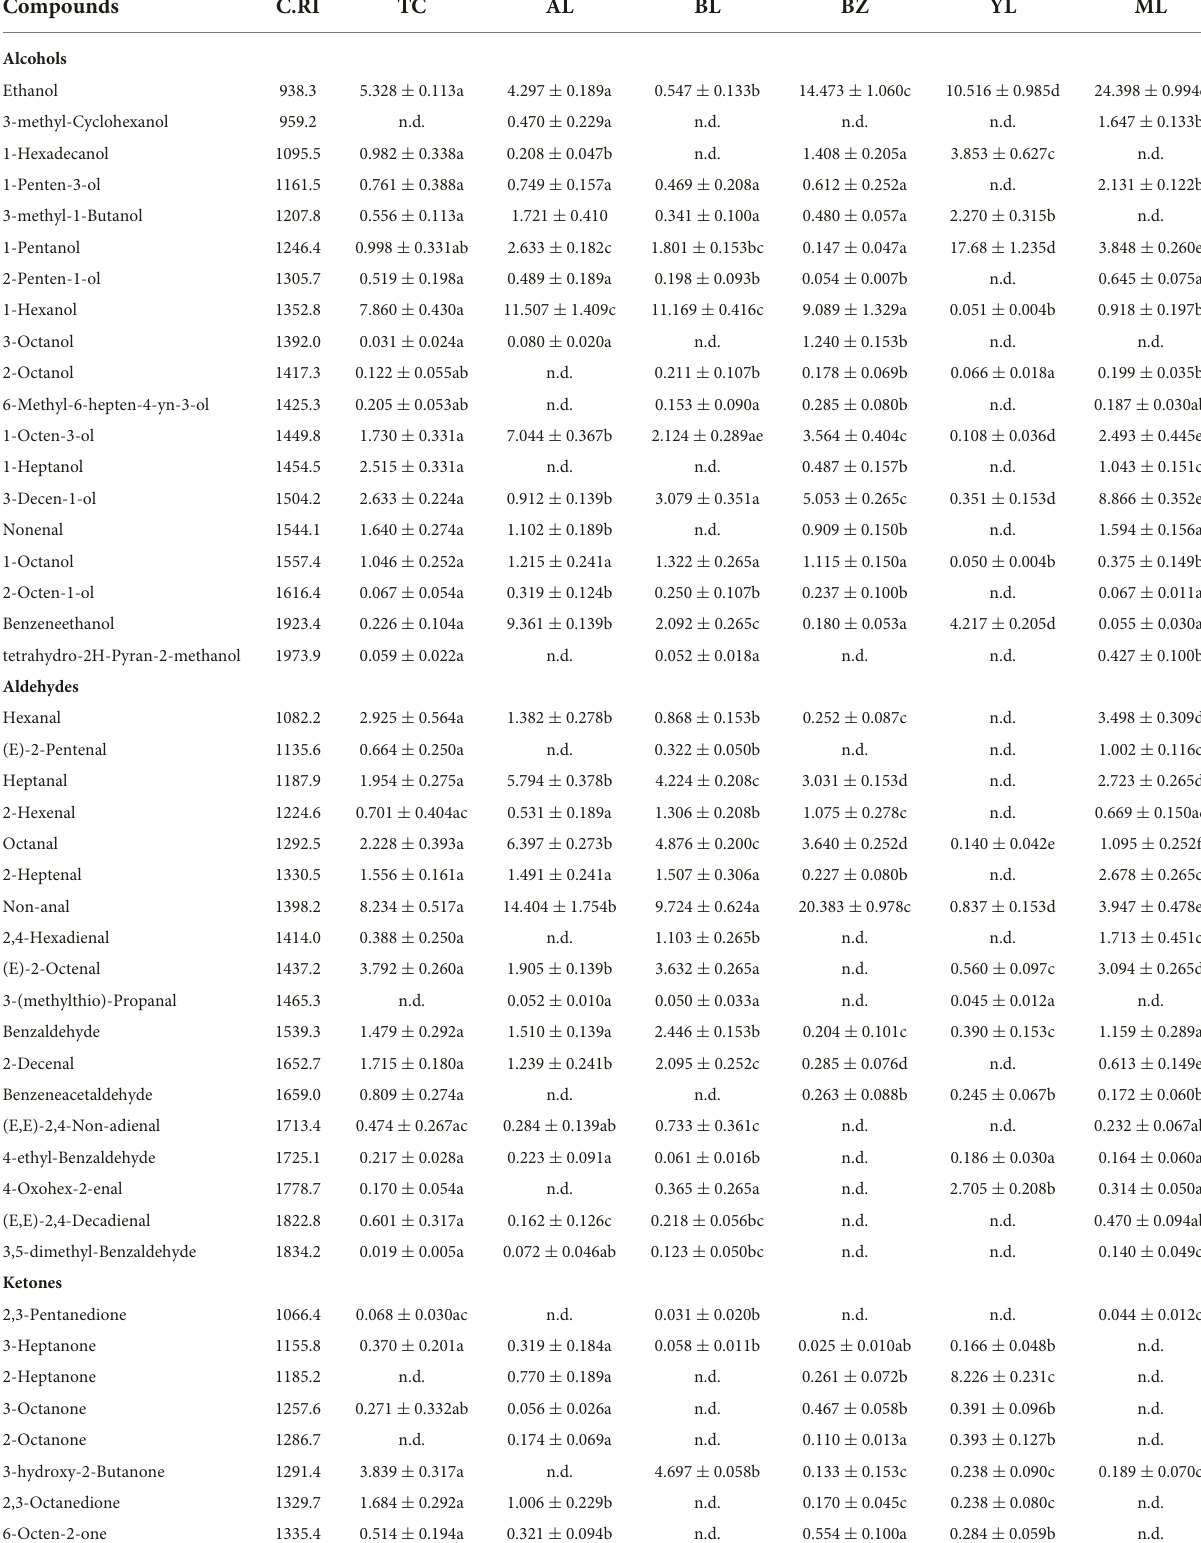
TABLE 2 Content (%) of volatile compounds in smoked horse meat sausages from different regions.